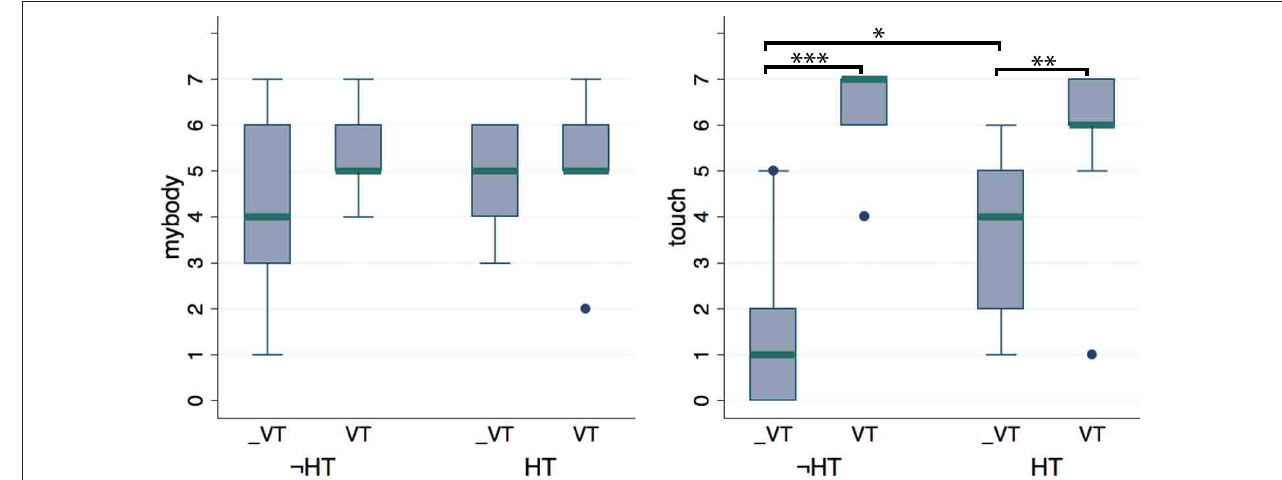
FIGURE 4 | Questionnaire data from experiment 1, in which we investigate the role of viusotactile and visual sensorimotor contingencies. No difference was found in the mybody item showing that the illusion was not affected by either of the two multisensory modalities (when a 1PP is provided over a realistic